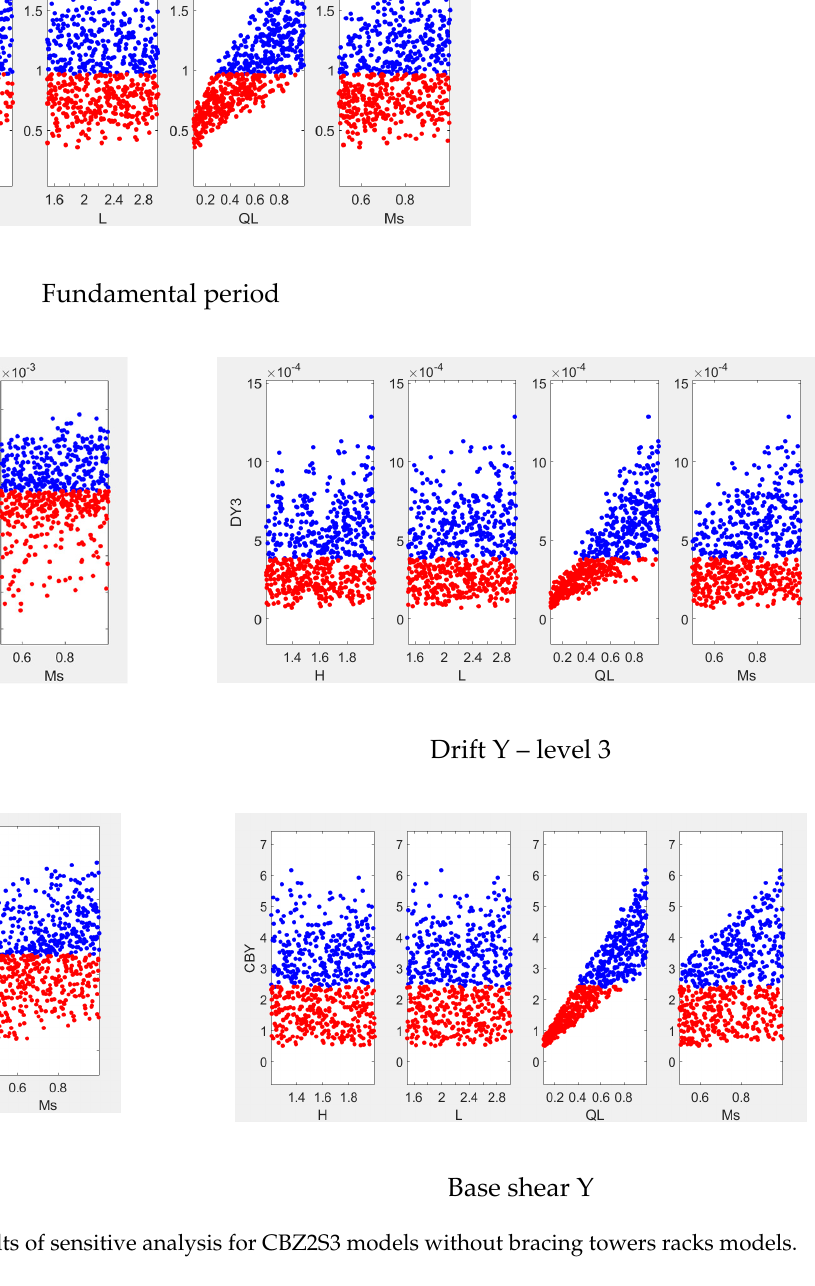
Figure 9. Results of sensitive analysis for CBZ2S3 models without bracing towers racks models.